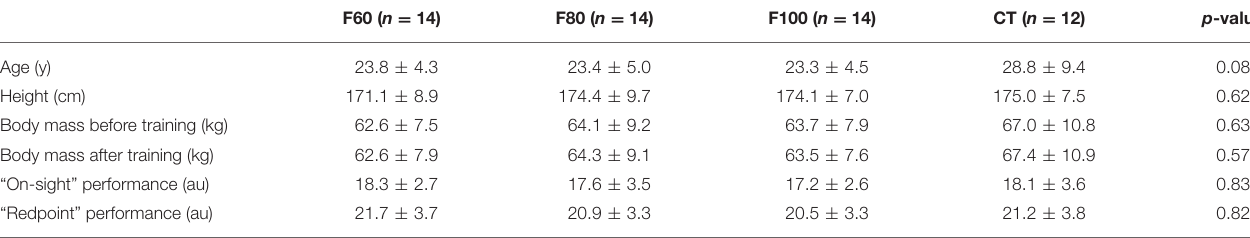
TABLE 1 | Descriptive characteristics of the participants of each group (mean ±